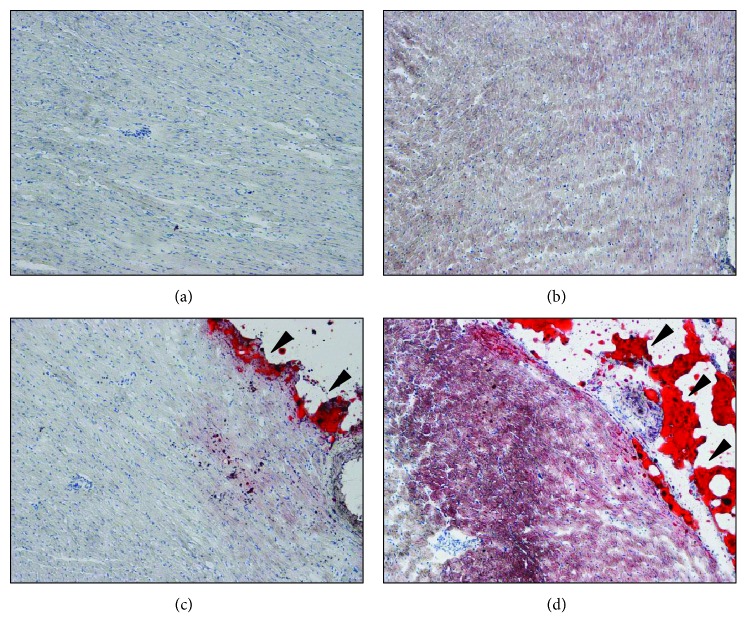
Fat staining on heart tissues. Ten μm heart cryostat sections were stained with Oil Red O dye. (a) and (c) are representative pictures of lean heart tissues and (b) and (d) of obese heart tissue. Red staining in (c) and (d) indicates (arrowheads) epicardial adipose tissue. Images were all captured at 10x magnification.